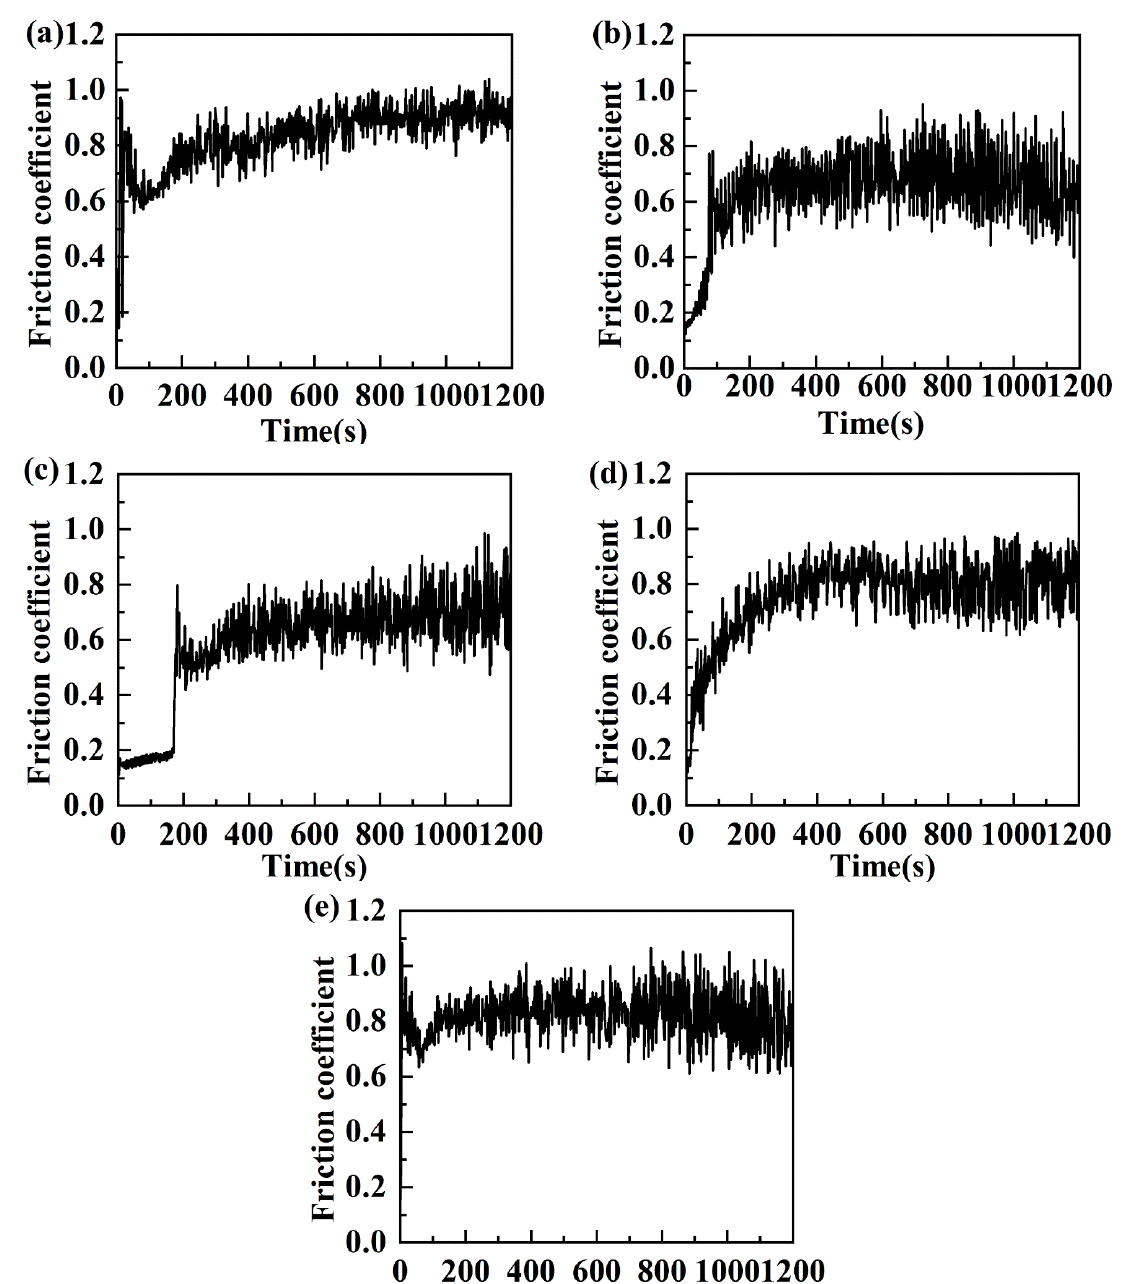
Figure 4. Friction coefficient curves of different samples: ( a ) untextured surface rotation radius 18 mm, ( b ) 0.4 mm groove width mechanical texture rotation radius 18 mm, ( c ) 0.6 mm groove width mechanical texture rotation radius 18 mm, ( d ) 0.8 mm groove width mechanical texture rotation radius 18 mm, and ( e ) 1.0 mm groove width mechanical texture rotation radius 18 mm.